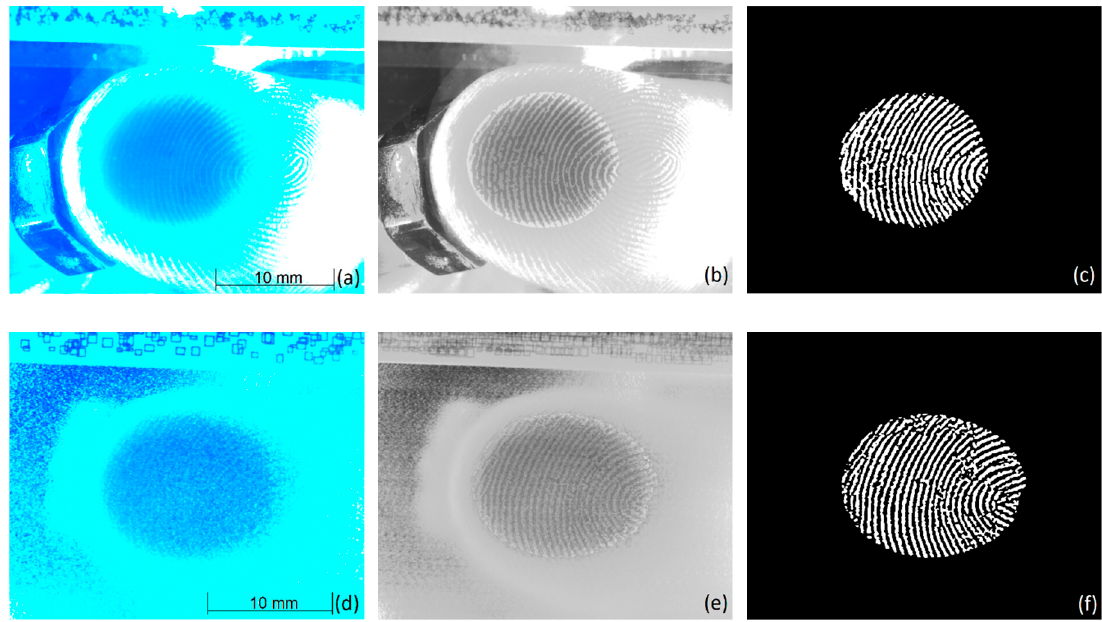
Figure 3. Contact area images and analysis for the surfaces ( a – c ) S1 and ( d – f ) S2 at a normal load of 2.0N. ( a , d ) Raw image with scale bar. ( b , e ) Grey scale average image with the extracted ridge contact area superimposed (note that for better visibility the non-contact area in the region of the apparent area is highlighted in bright grey). ( c , f ) Extracted epidermal ridges in contact with the surface (white structures). Images recorded during movement. Images ( a , b ) and ( d , e ) additionally show the visual code mounted on the specimen to extract the lateral shift between consecutive images.